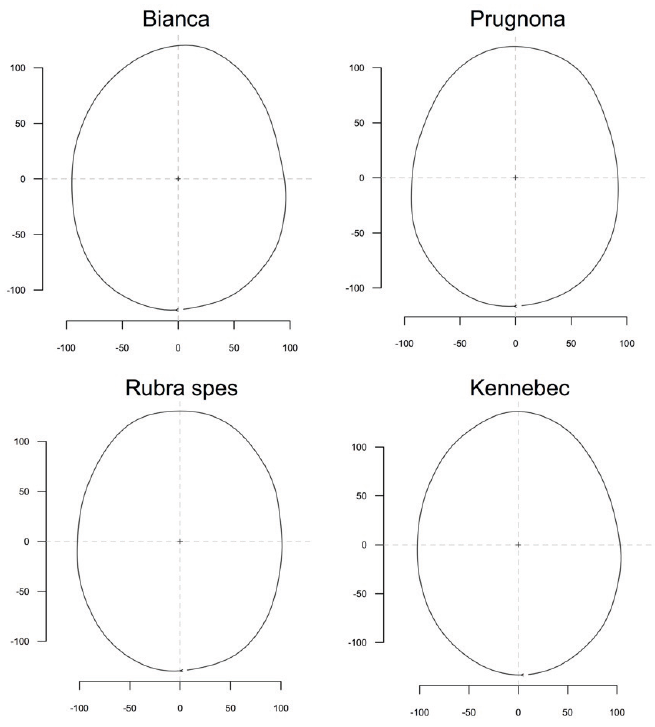
Fig. 3: Mean shape of tubers assigned to the four potato genotypes accord- ing to elliptical Fourier descriptors analysis.